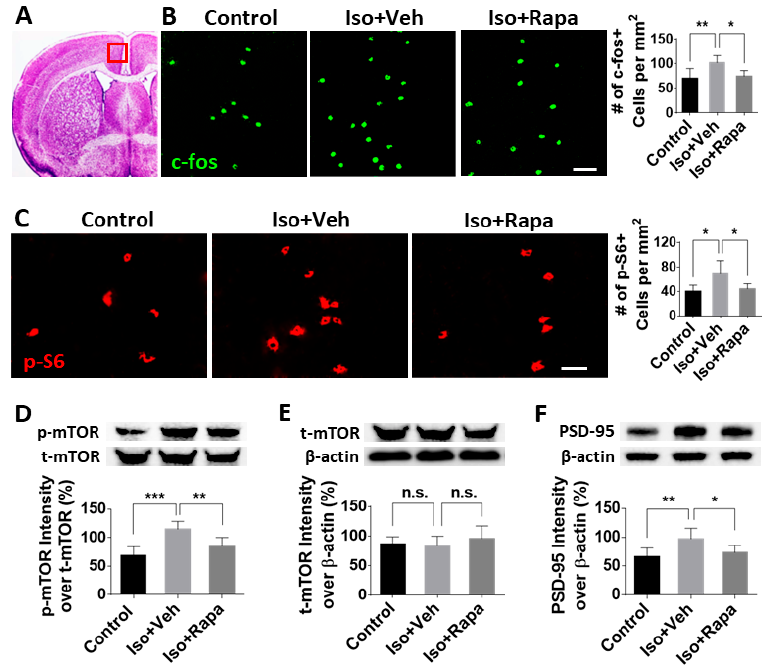
Figure 3. Neuronal activity and mTOR level in the anterior cingulate cortex (ACC). ( A ) Coronal brain section with ACC. Red box represents the location in Figures B and C. ( B ) Isoflurane upregulated the number of c-fos-positive neurons in ACC and rapamycin reversed this effect. Bar = 50 μ m. ( C ) Number of pS6-immunolabeled cells in isoflurane-exposed mice was greater than in the control. Rapamycin decreased this number. Bar = 50 μ m. ( D ) WB data showing phosphorylation of mTOR in ACC. The ratio of p-mTOR intensity over t-mTOR was enhanced by isoflurane exposure and reversed with rapamycin treatment. ( E ) The ratio of t-mTOR over β -actin was identical in all groups. ( F ) PSD95 level in ACC. WB showed the ratio of PSD95-positive band over β -actin was significantly upregulated